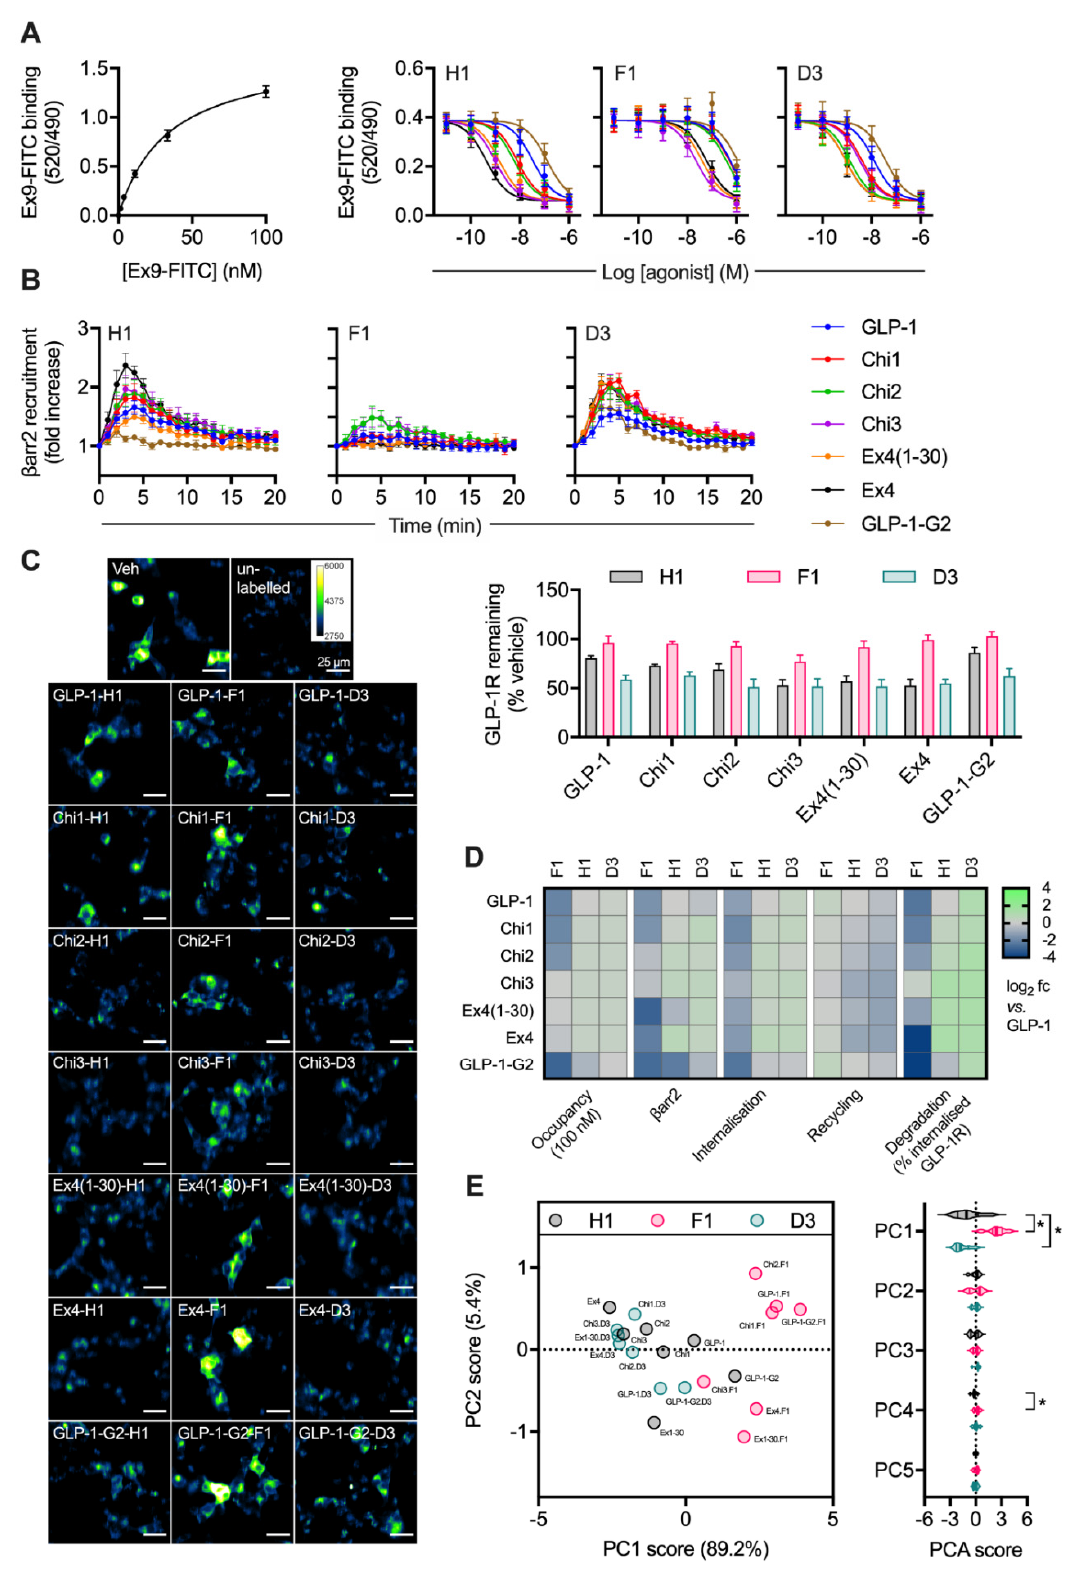
Figure 3. Relationship between binding affinity and GLP-1R degradation rate with N-terminally substituted GLP-1R agonists. ( A ) TR-FRET equilibrium binding affinity assays performed in HEK293-SNAP-GLP-1R cells, with saturation binding of exendin(9-39)-FITC (“Ex9-FITC”) and effect of indicated unlabelled agonist on binding of 10 nM exendin(9-39)-FITC in parallel experiments, n = 6. ( B ) β -arrestin-2 recruitment to GLP-1R in HEK293T cells, measured using nanoBiT complementation,